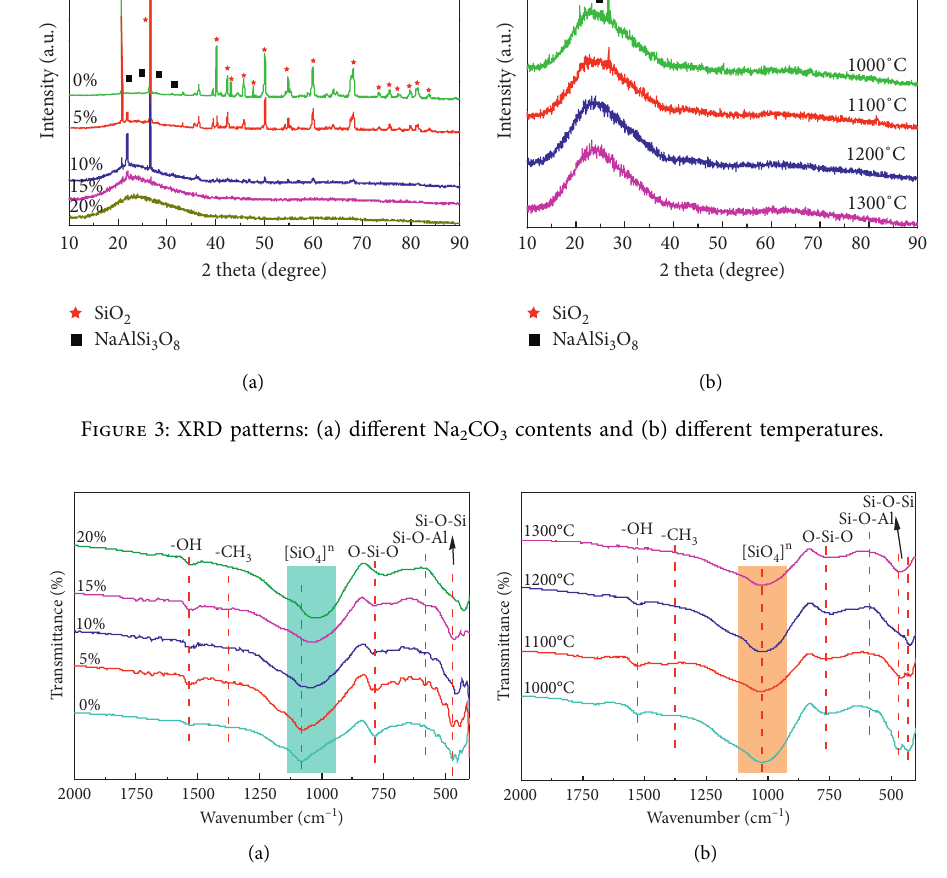
2 CO 3 and (b) different temperatures.